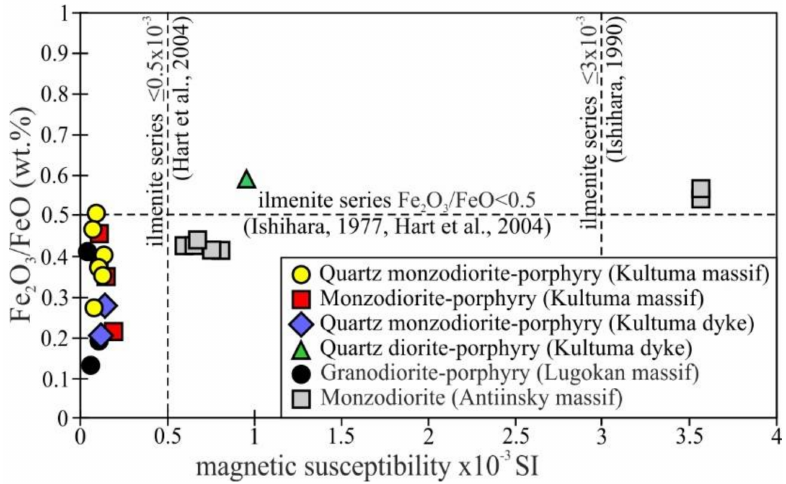
Figure 5. Discriminant diagram Fe 2 O 3 /FeO vs. magnetic susceptibility (showing a correlation between magnetic susceptibility and iron oxidation